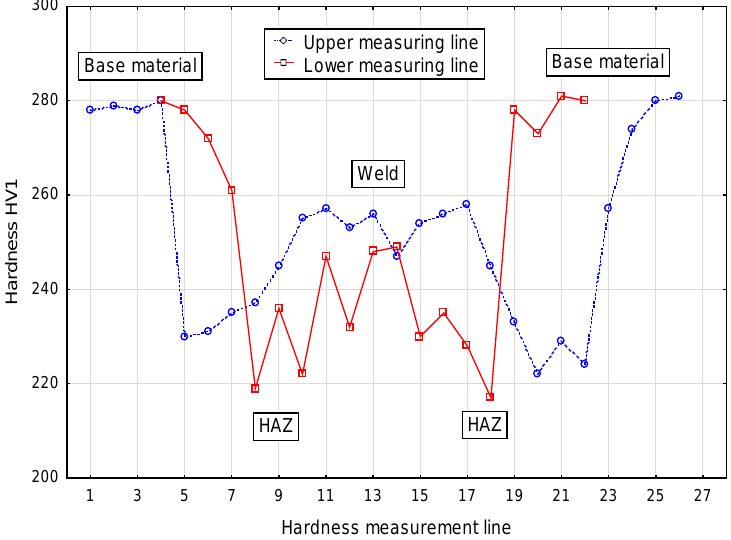
Figure 11. Hardness of the hybrid weld joint (laser beam-MAG) made of S700MC steel (position of measuring lines 2 mm from the top and bottom surface of the sheet).